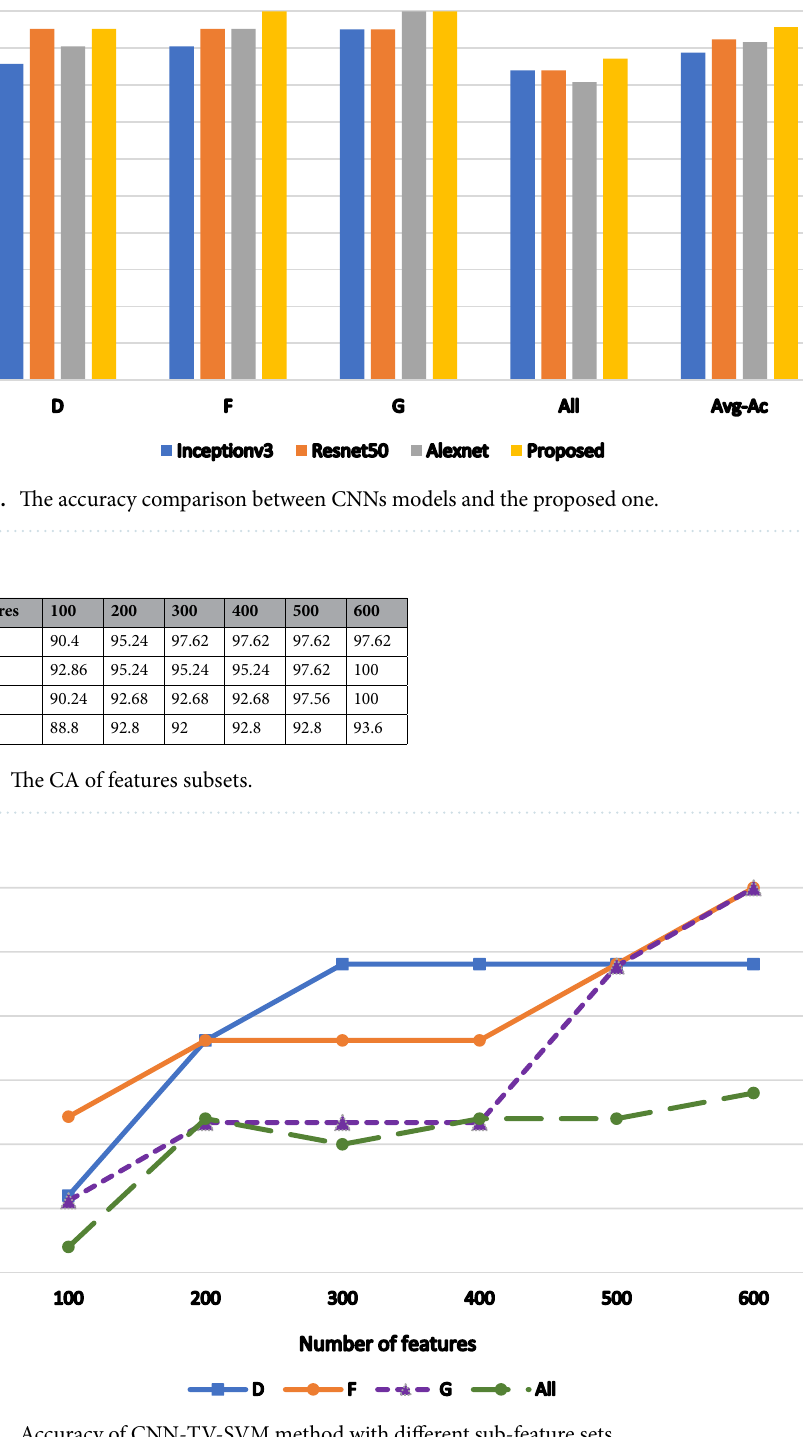
Figure 3. Accuracy of CNN-TV-SVM method with different sub-feature